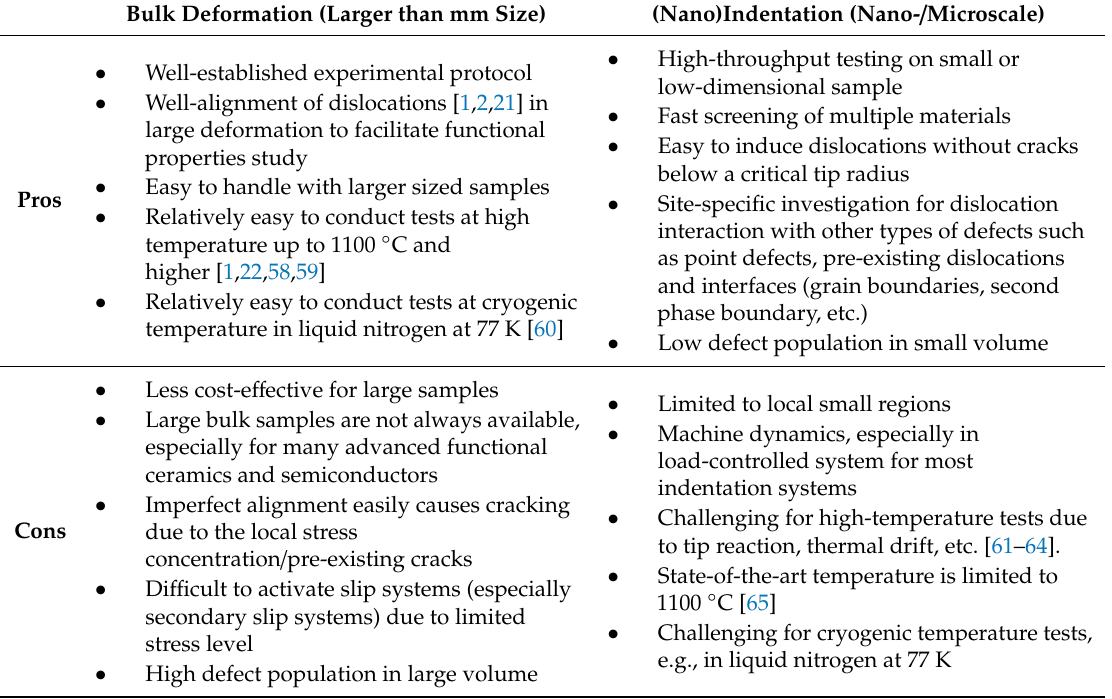
Table 1. Comparison of the advantages and limitations between bulk and indentation